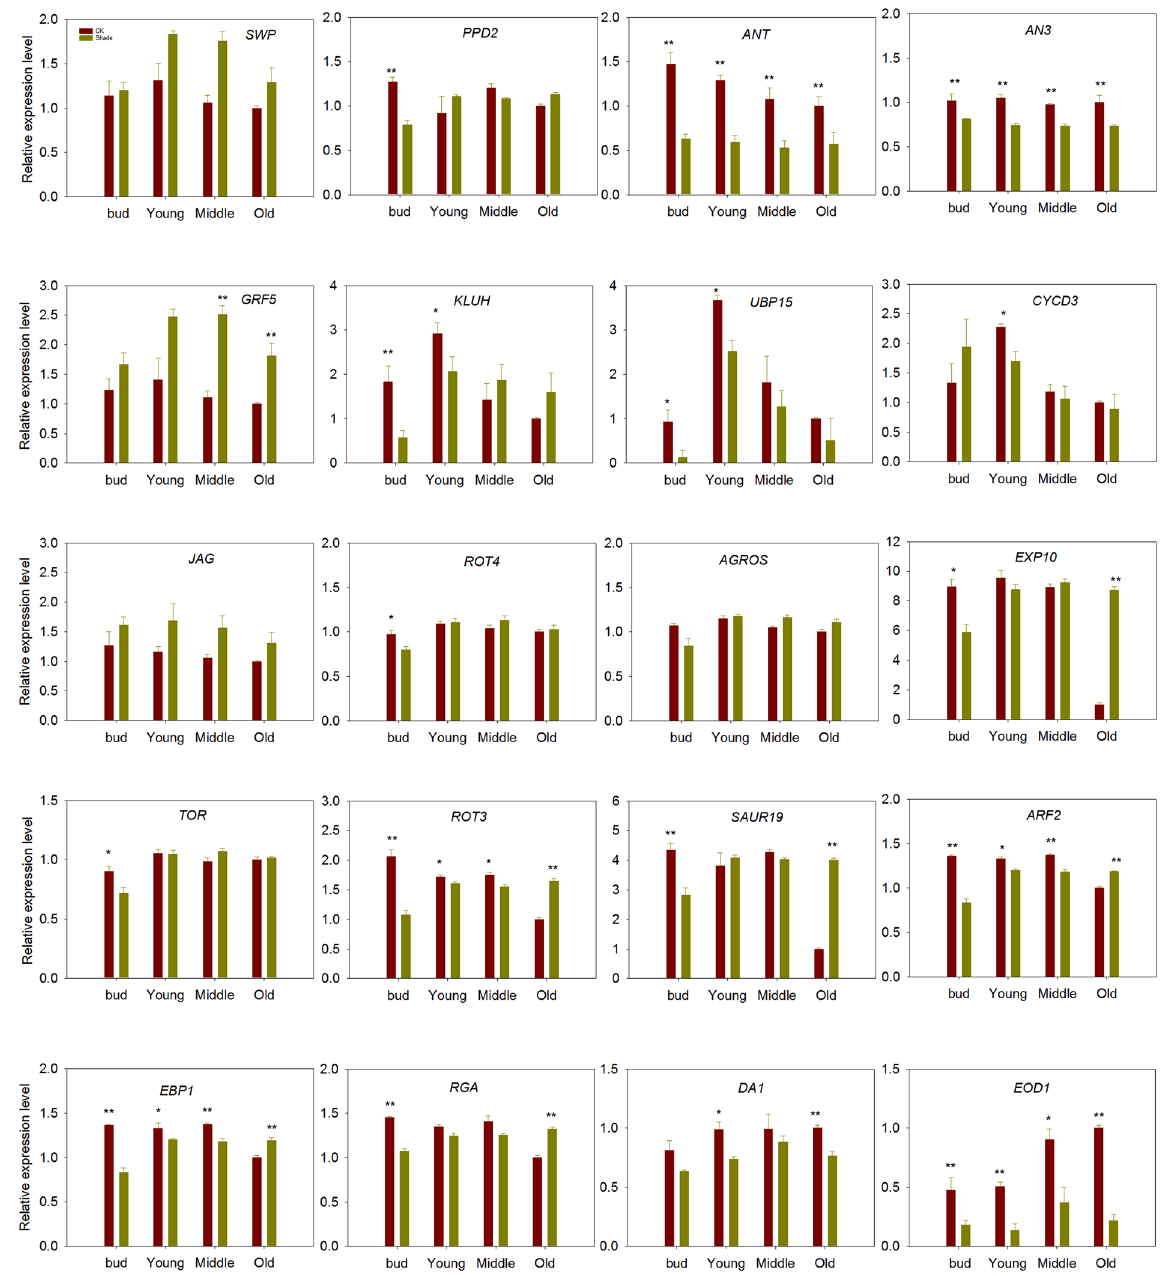
Figure 6. Expression levels of 20 cell proliferation and/or enlargement genes in young, middle and old leaves of 30 days old soybean plants grown in shade or full sunlight (CK). Expression levels are normalized with respect to the housekeeping gene ACT and are displayed relative to a value of unity for old leaves in full sunlight. Values are mean ± SD (n = 6). Statistical significance assessed by Duncan’s t-test. * and ** indicates significant at 0.05 and 0.01 probability level,